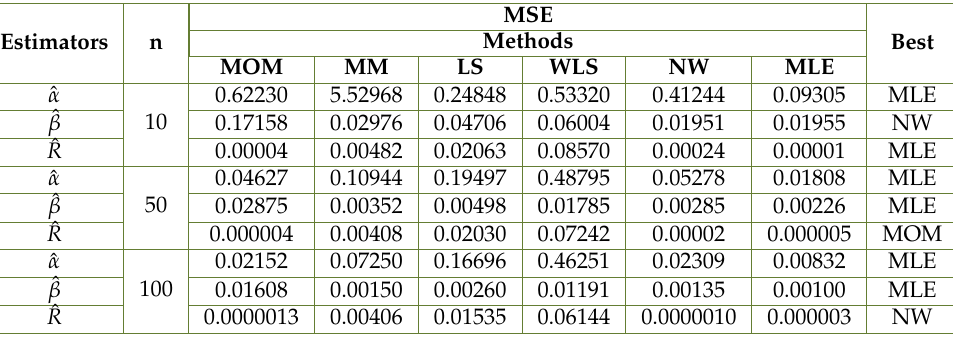
Table 3. Estimated values for ( α , β ) and ( R ) using ( E 2 )